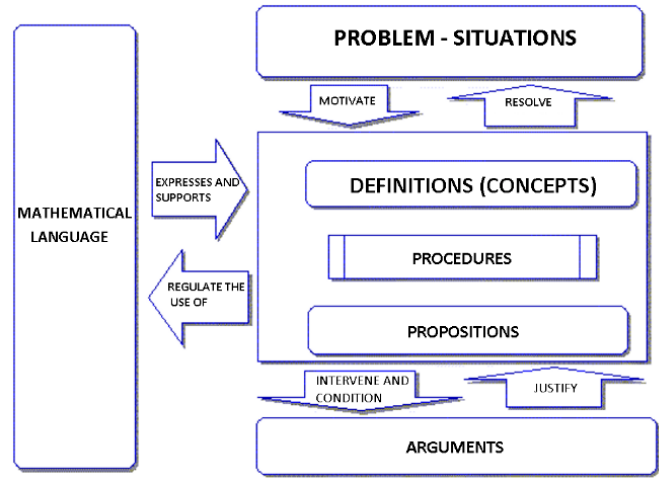
Figure 1. Components and relationships in an epistemic configuration. The mathematical object is considered a human product to resolve different problem situations, generating elements such as definitions, procedures, and propositions, justified by arguments and expressed by the language (“Componentes y relaciones en una configuración epistémica” by [31], licenced under CC BY-NC-ND 4.0 / translated from original ).